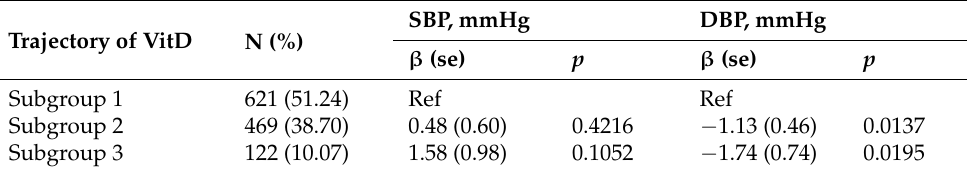
Table 4. The association between the trajectory of VitD during pregnancy and blood pressure at T3. Trajectory of